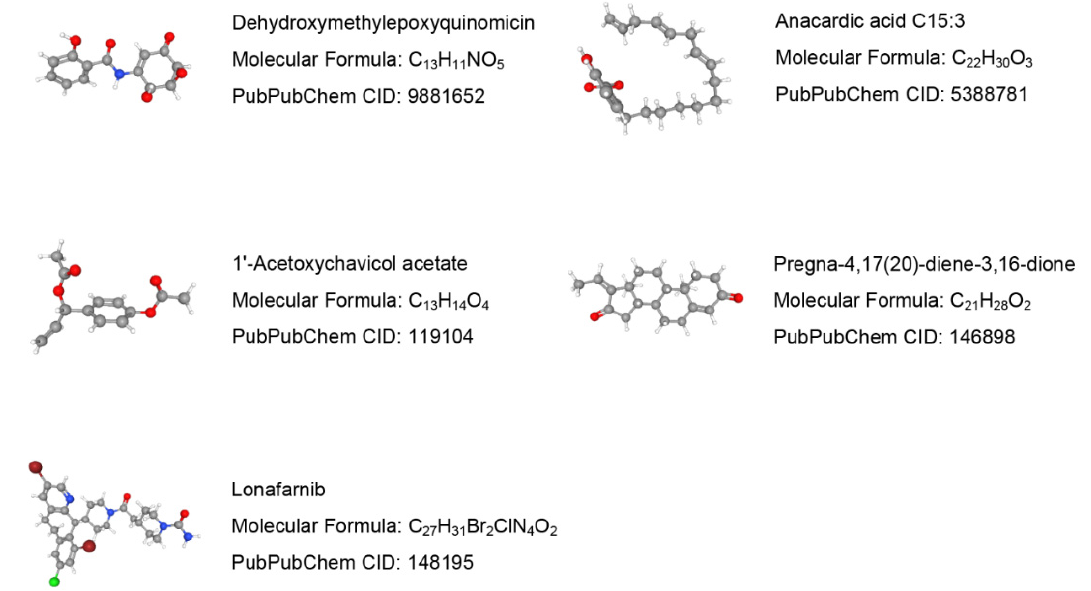
Figure 12. Prediction results of potential small molecule drugs for treating COPD based on 7 target genes.